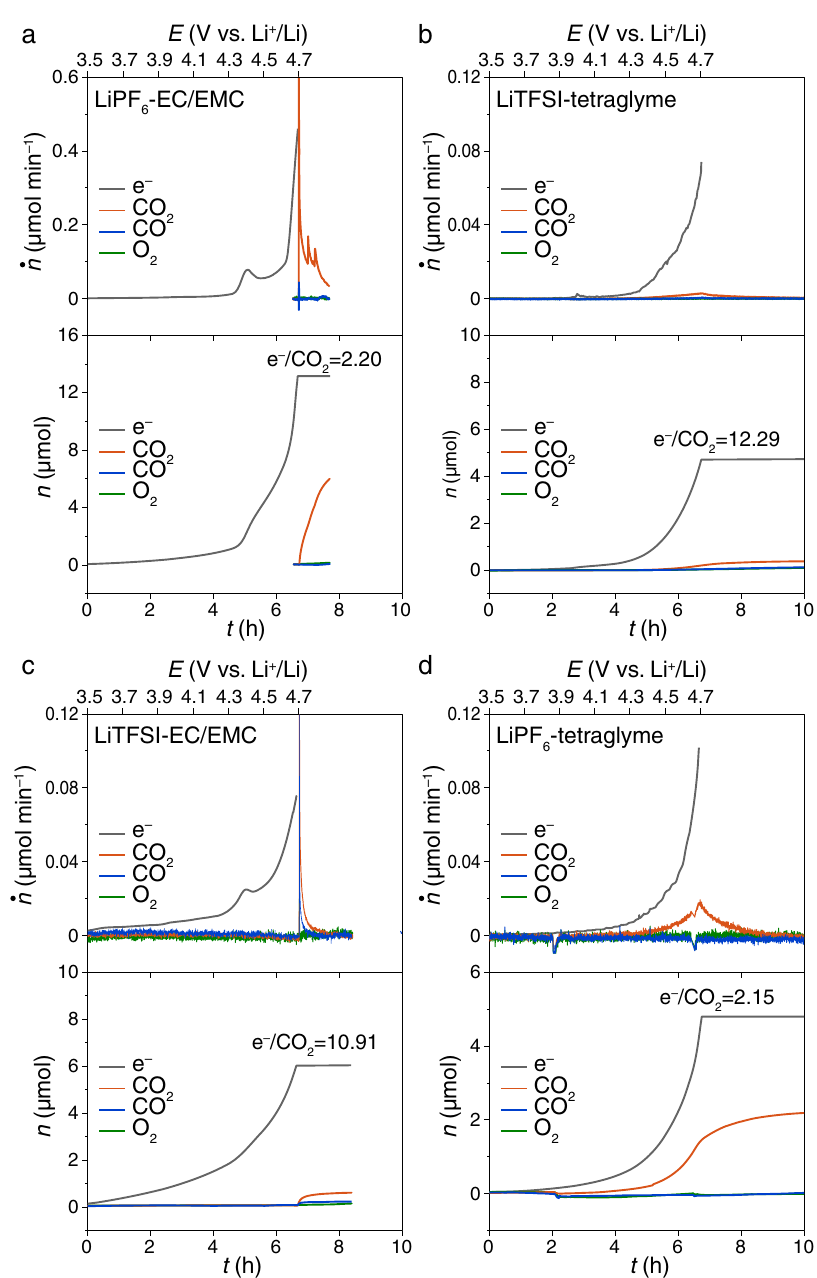
Fig.5|Impactofelectrolytesaltsandsolventsonthegasevolutionofchemical decomposition of Li 2 CO 3 . The gas evolution during the charging process of the cells using Super P-PTFE composite electrodes without direct contact of Li 2 CO 3 in a 1M LiPF 6 -EC/EMC, b 1M LiTFSI-tetraglyme. c 1M LiTFSI-EC/EMC, and d 1M LiPF 6 - tetraglyme. 20mg of commercial Li 2 CO 3 was separated from the Super P-PTFE